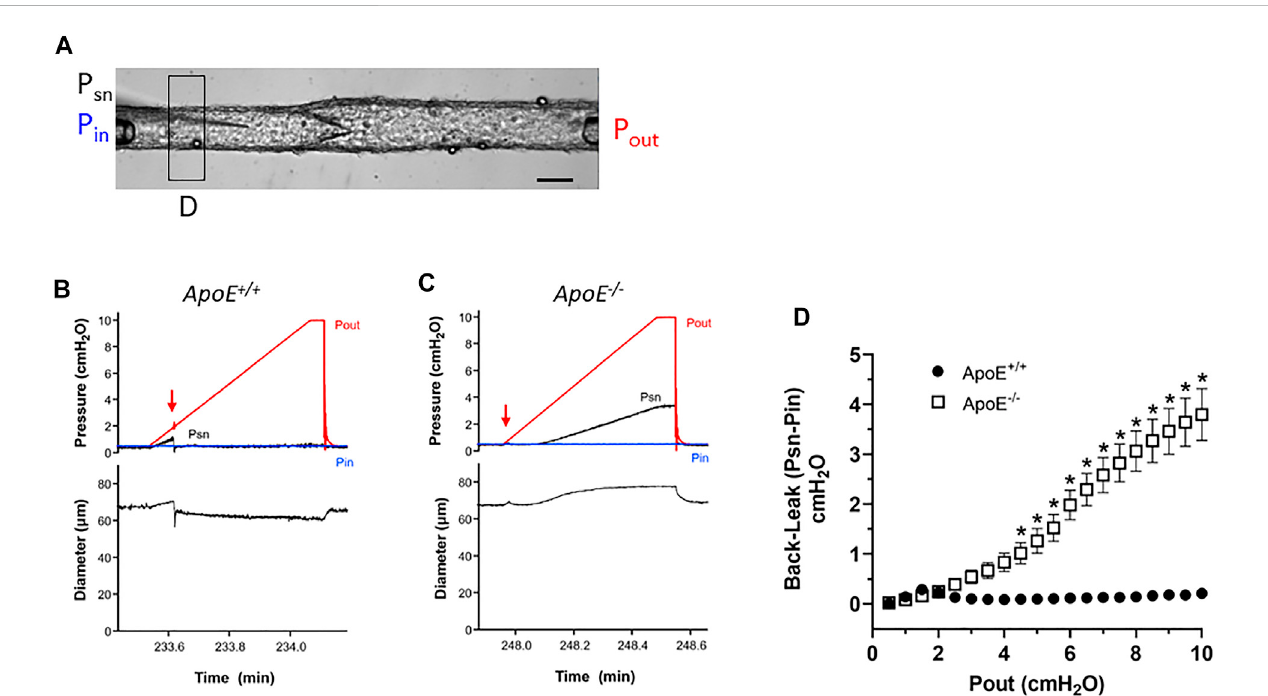
FIGURE 2 ApoE − / − valves exhibit increased back-leak. (A) Experimental con fi guration used for valve tests. Calibration bar = 40 μ m. (B – C) Examples of back-leak tests over the pressure range 0 – 10 cmH 2 O for isolated valves from ApoE +/+ and ApoE − / − popliteal lymphatics. When closed, the ApoE +/+ valve showed only very slight back leak (B) , comparable to that of normal valves in previous studies; (C) in contrast, the ApoE − / − valve began to leak when Pout exceeded ~3 cmH 2 O. (D) Summary data show that ApoE +/+ valves, when closed, effectively prevent back-leak whereas ApoE − / − valves consistently showed back- leak when Pout exceeded ~3 cmH 2 O; back-leak was signi fi cant at all Pout levels ≥ 4 cmH 2 O. Statistical differences were assessed via mixed-effects model ANOVAs with Geisser-Greenhouse correction with Sidak ’ s multiple comparisons